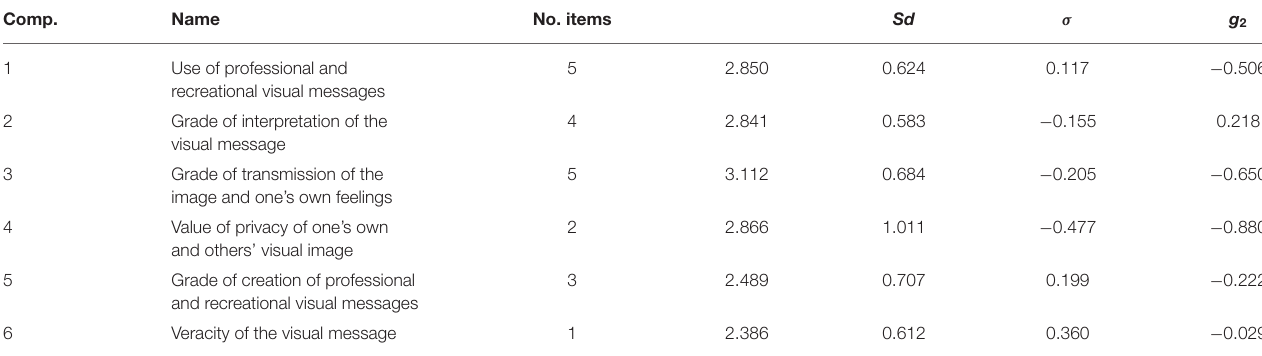
TABLE 1 | Descriptive statistics of recoded variables. Comp.